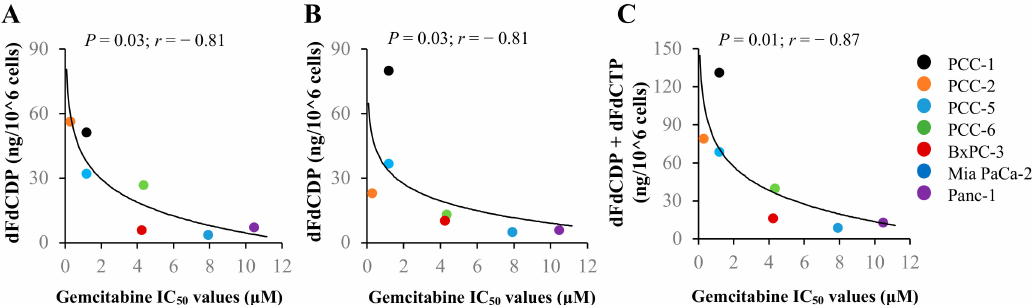
Figure 7. Assessment of the correlation between gemcitabine sensitivity and levels of its active metabolites. Correlation plots of gemcitabine IC 50 values vs. levels of ( A ) dFdCDP, ( B ) dFdCTP, and ( C ) dFdCDP + dFdCTP. IC 50 values for gemcitabine were calculated using GraphPad Prism 6 software. Non-linear logarithmic regression was applied for the variable vs. IC 50 values and were analyzed by the Spearman correlation test. dFdC, 2 (cid:48) ,2 (cid:48) -difluoro-2 (cid:48) -deoxycytidine (gemcitabine); dFdCDP, gemcitabine diphosphate; dFdCTP, gemcitabine triphosphate; PCC, pancreatic cancer